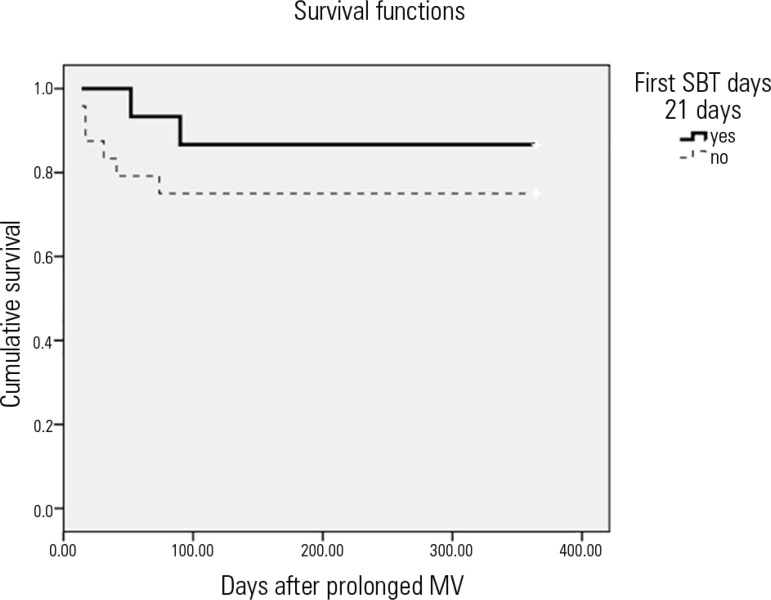
One-year Kaplan-Meier survival curve for patients with prolonged
mechanical ventilation who received a spontaneous breathing trial.Yes: first SBT initiated after 21 consecutive days of MV; No: first SBT
before 21 days of MV; p = 0.31. SBT - spontaneous breathing trial; MV -
mechanical ventilation.